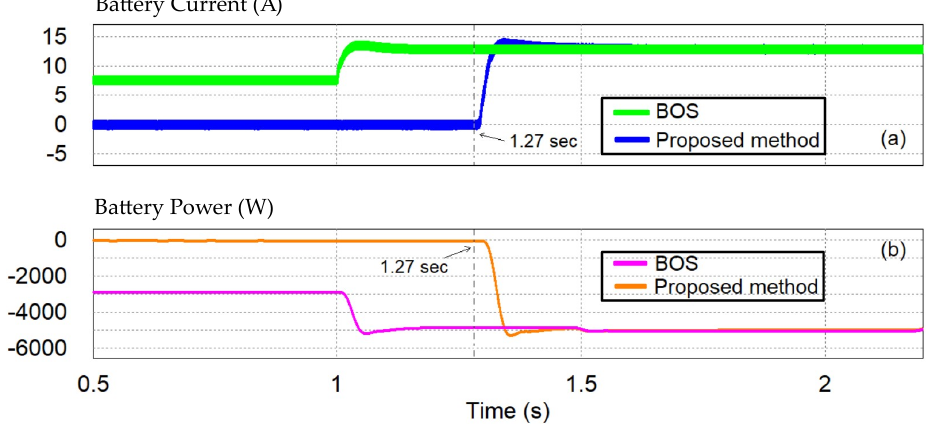
Figure 15. ( a ) The SCES voltage; ( b ) the SCES power—Case 2.